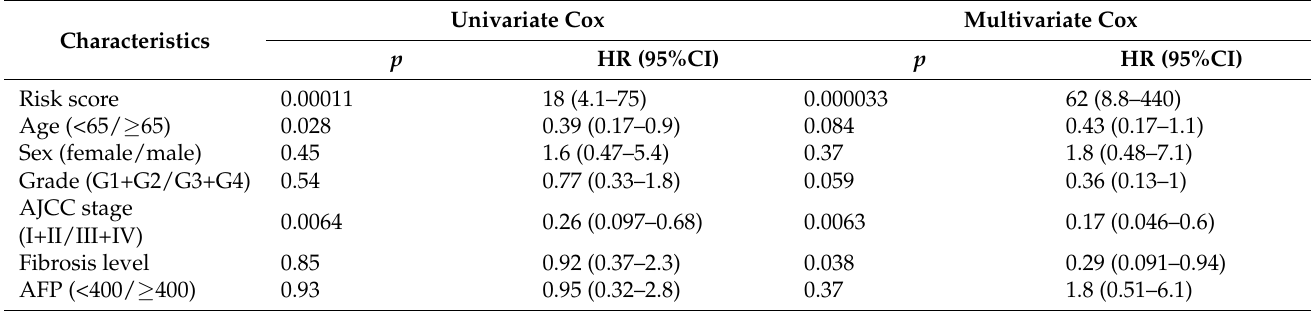
Figure 4. Validation of the prognostic performance of the FAM-related signature in the TCGA-LIHC dataset. ( a ) Time-dependent ROC curve of risk score model for 1-, 3- and 5-year overall survival predictions. ( b ) Heatmap of the five-gene expression in the TCGA cohort. ( c ) Boxplot of risk scores for different states. ( d ) Kaplan–Meier survival curves of the risk score model. Table 2. Univariate and multivariate Cox regression analysis of TCGA-LIHC